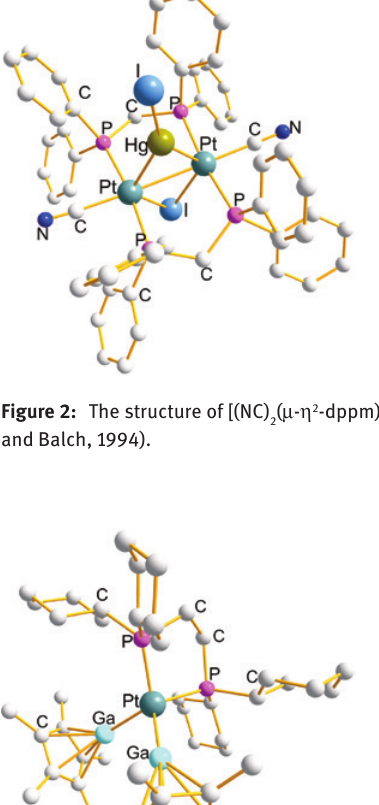
Figure 3: The structure of [( η 2 -dcpe)Pt{Ga( η 5 -cp * )}